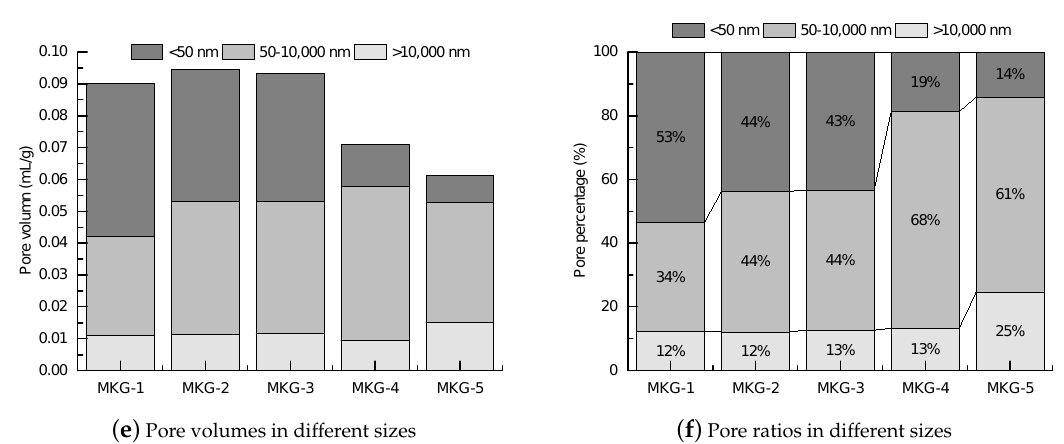
Figure 9. Pore structure of the MKG mortars after F-T loads: ( a ) APSD spectra; ( b ) DPSD spectra; comparison of the pores in Phase A ( c ) and Phase B ( d ); ( e ) pore volumes in different sizes; and ( f ) pore ratios in different